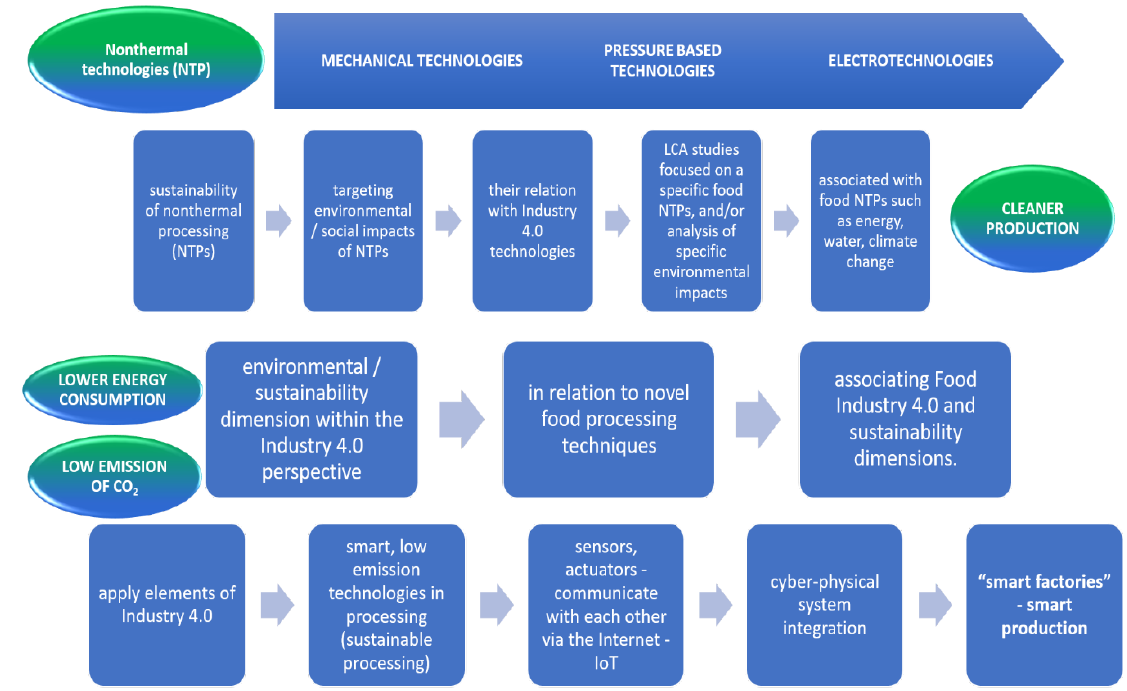
Figure 1. Nonthermal technologies in connection with elements of Industry 4.0 and sustainability dimensions.